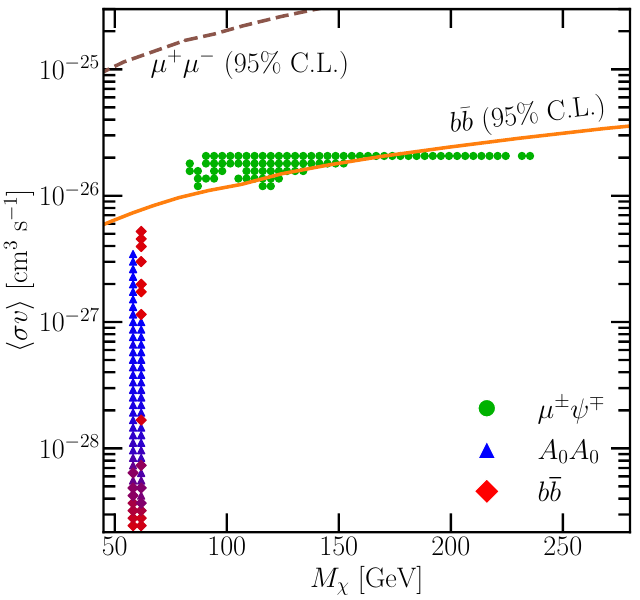
Figure 6 . The 2 σ allowed samples projected to ( M χ , h σv i ) plane. The upper limit of dSphs gamma ray data for final state bb [99] and µ + µ − [77] is depicted for reference. Different color and shape indicate the dominant DM annihilation